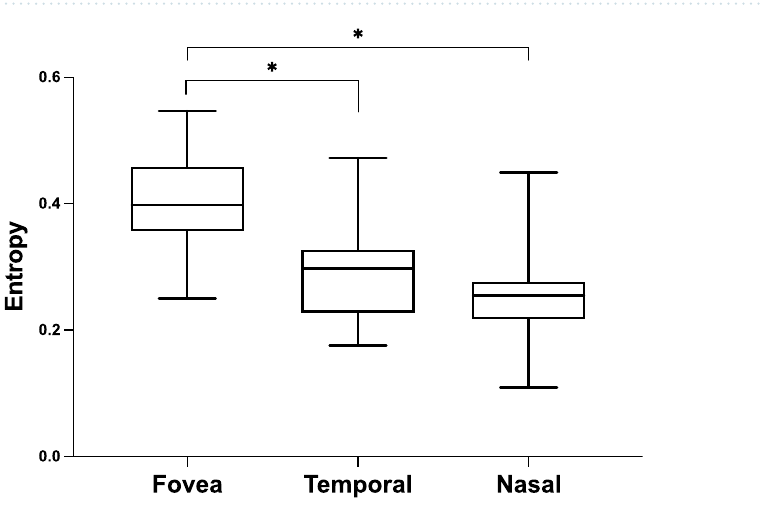
Figure 4. Box and whisker plots of entropy for three sections. The horizontal line in the box represents the median. The top and bottom sections of the box represent the upper and lower quartiles, respectively. The whisker above the box represents the values within 1.5 times the interquartile range plus the upper quartile, and the whisker below the box represents the values within 1.5 times the interquartile range minus the lower quartile. *Statistically significant at P <